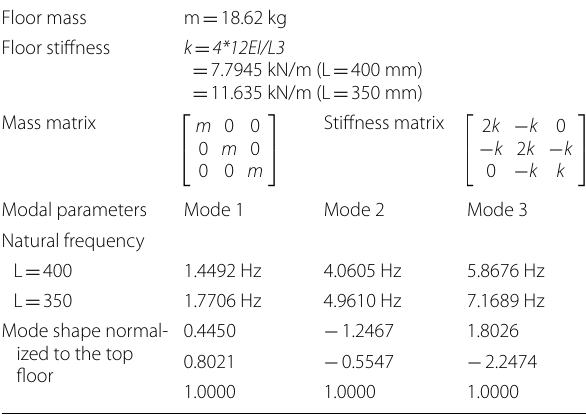
Table 1 Dynamic parameters of the